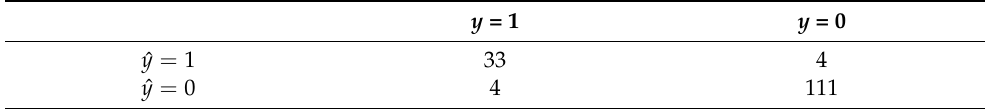
Table 2. Confusion matrix of WRF-Chem forecasting for Black Sea region from 20.05.2020